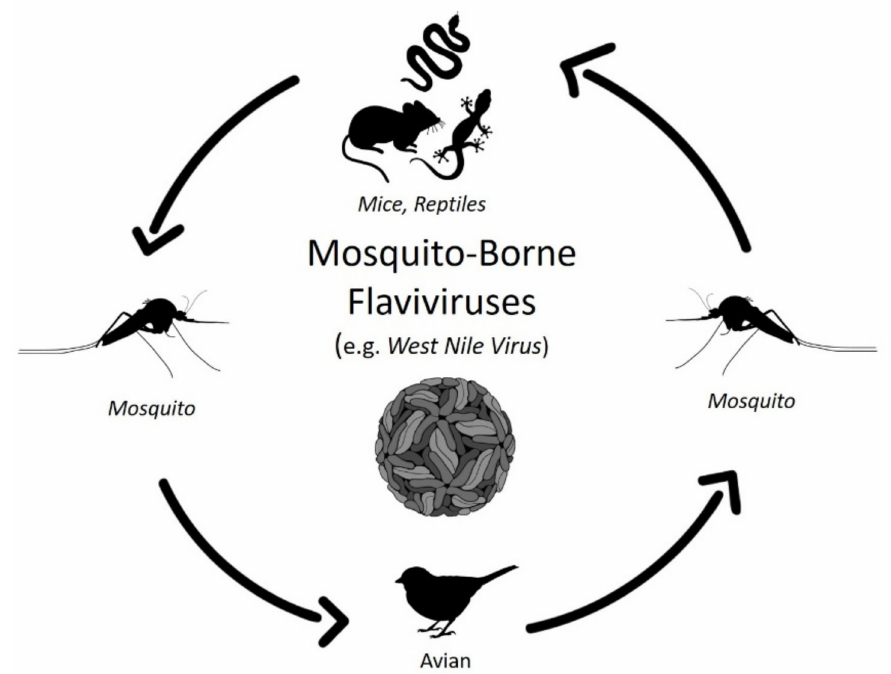
Figure 2. Schematic Representation of the Mosquito-Borne Flavivirus Transmission Cycle